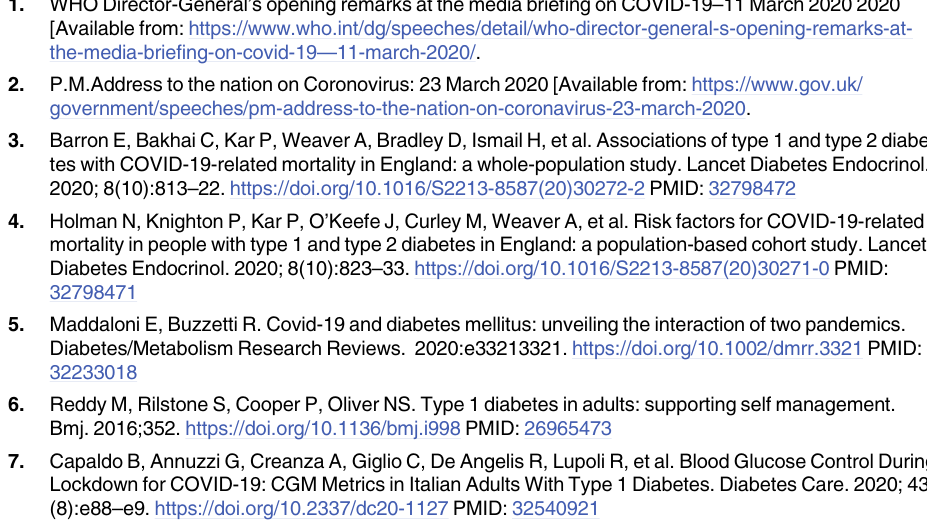
S1 Fig. Recruitment flowchart. Abbreviations: FSL, flash glucose monitoring; rtCGM, real- time continuous glucose monitoring. S2 Fig. Box plot to demonstrate the change in %TIR by tertiles for adults and children included in the pair-wise analysis (n = 145) using the English index of multiple deprivation 2019. The “most deprived” tertile include deciles 1–3 (n = 52), the “moderately deprived” ter- tile includes deciles 4–5 (n = 43) and the “least deprived” tertiles includes deciles 6–10 (n = 50). Abbreviations: TIR, time in